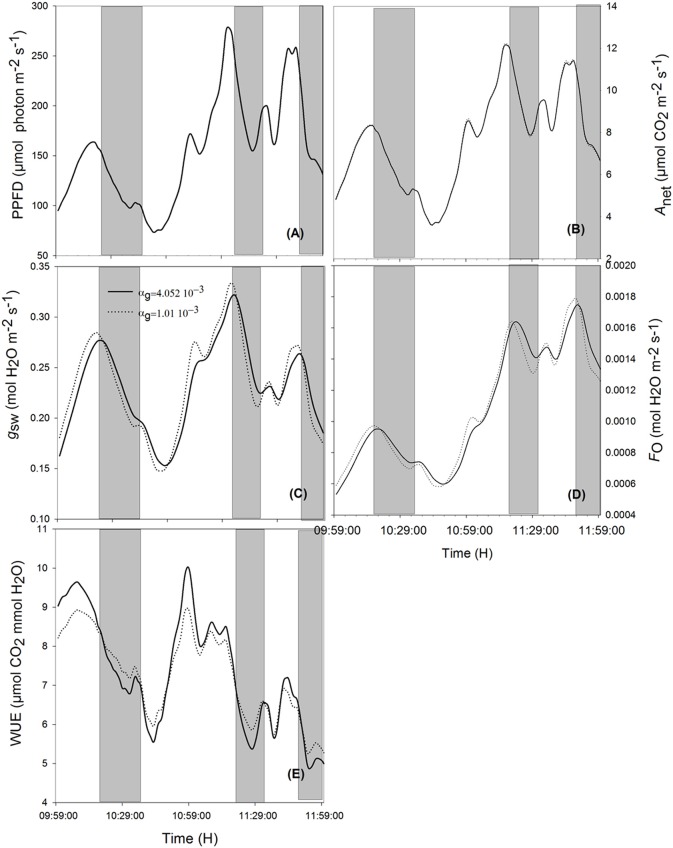
Effects of varying the time constant for stomata response (αg) on net assimilation rate (B), stomatal conductance (C), transpiration rate (D), water use efficiency (E) for different photosynthetic active radiation (PAR; A) during the cloudy day. Simulations were performed in steps of 1 s over 2 h (from 10:00 a.m. to 12:00 p.m.) and are extracted from measurements over 2 days' data. Solid lines represent the slowest stomata opening/closing (αg = 4.052 10−3) and dotted lines represent the simulation result for αg = 1.01 10−2. Shaded areas correspond to the period where slower reacting stomata have a higher water use efficiency. Other climatic data were extracted from the 2 days' measurement data presented in Figure 1 and all other parameter values are defined in Tables 1, 2.